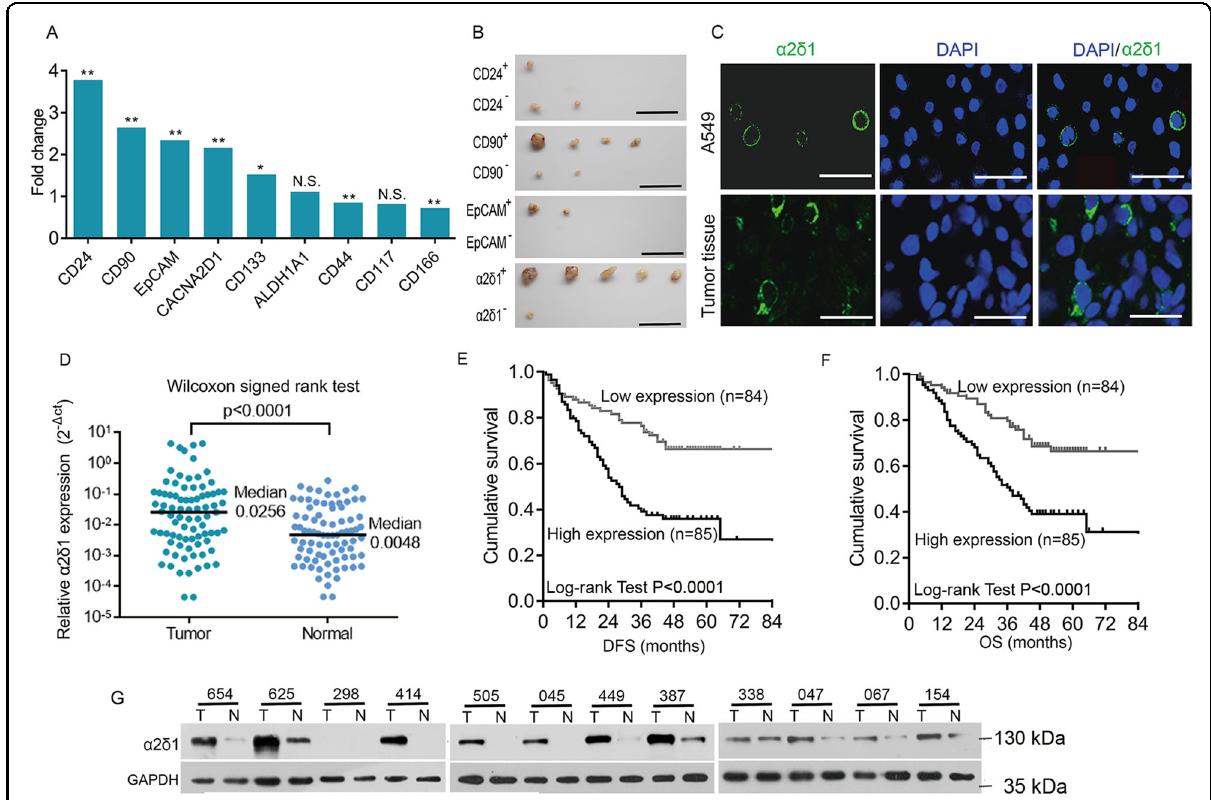
Fig. 1 Identi fi cation of α 2 δ 1 as a candidate marker for NSCLC TICs. A Transcriptome analysis shows the relative expression of the indicated molecules in NSCLC tissues including lung adenocarcinoma ( n = 125) and squamous carcinoma ( n = 224) compared with those in normal tissues ( n = 54) from the TCGA database. * p ≤ 0.05, ** p ≤ 0.001, n.s., no signi fi cance, P >0.05, Mann – Whitney test. B Represented images showing the dissected tumors formed by 1000 cells per site of the indicated fractions puri fi ed by FACS from A549 cell line (n = 5). Scale bars, 2 cm. C Immuno fl uorescent staining for α 2 δ 1 with mAb 1B50-1 in A549 cells and cryostat section of primary NSCLC tissue. Nuclei were stained with DAPI. Scale bar, 50µm. D The relative expression levels of α 2 δ 1 to GAPDH mRNA in NSCLC tissues and paired normal tissues adjacent to tumors ( n = 83) as measured by qRT-PCR. E , F Kaplan – Meier curves showing the disease-free survival (DFS) and overall survival (OS) of the patients with high and low levels of α 2 δ 1 mRNA in NSCLC tissues, which were divided according to the cutoff of 0.0155, the median value of α 2 δ 1 relative to GAPDH mRNA. G Western blot results showing the expression of α 2 δ 1 protein in 12 pairs of fresh NSCLC (T) and adjacent normal (N)